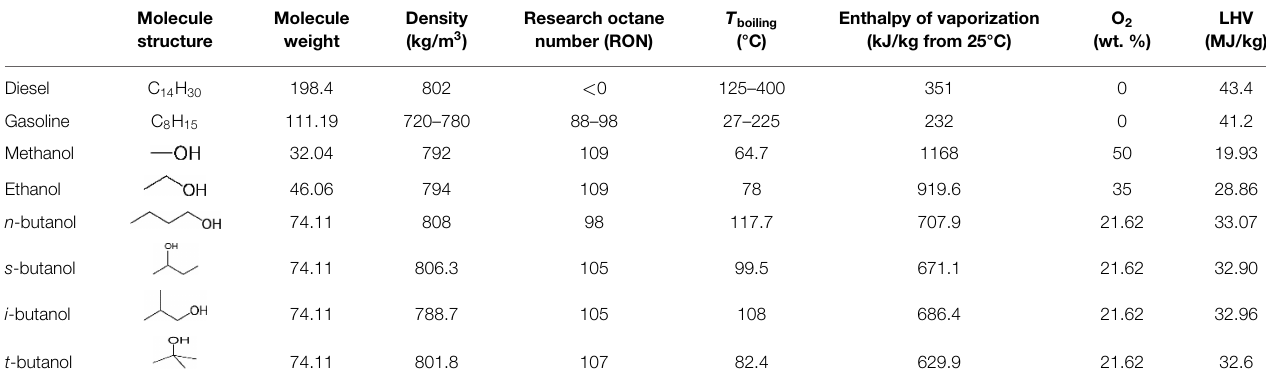
TABLE 1 | Major properties of diesel, gasoline, and alcohols (Sarathy et al., 2014) . Molecule Molecule